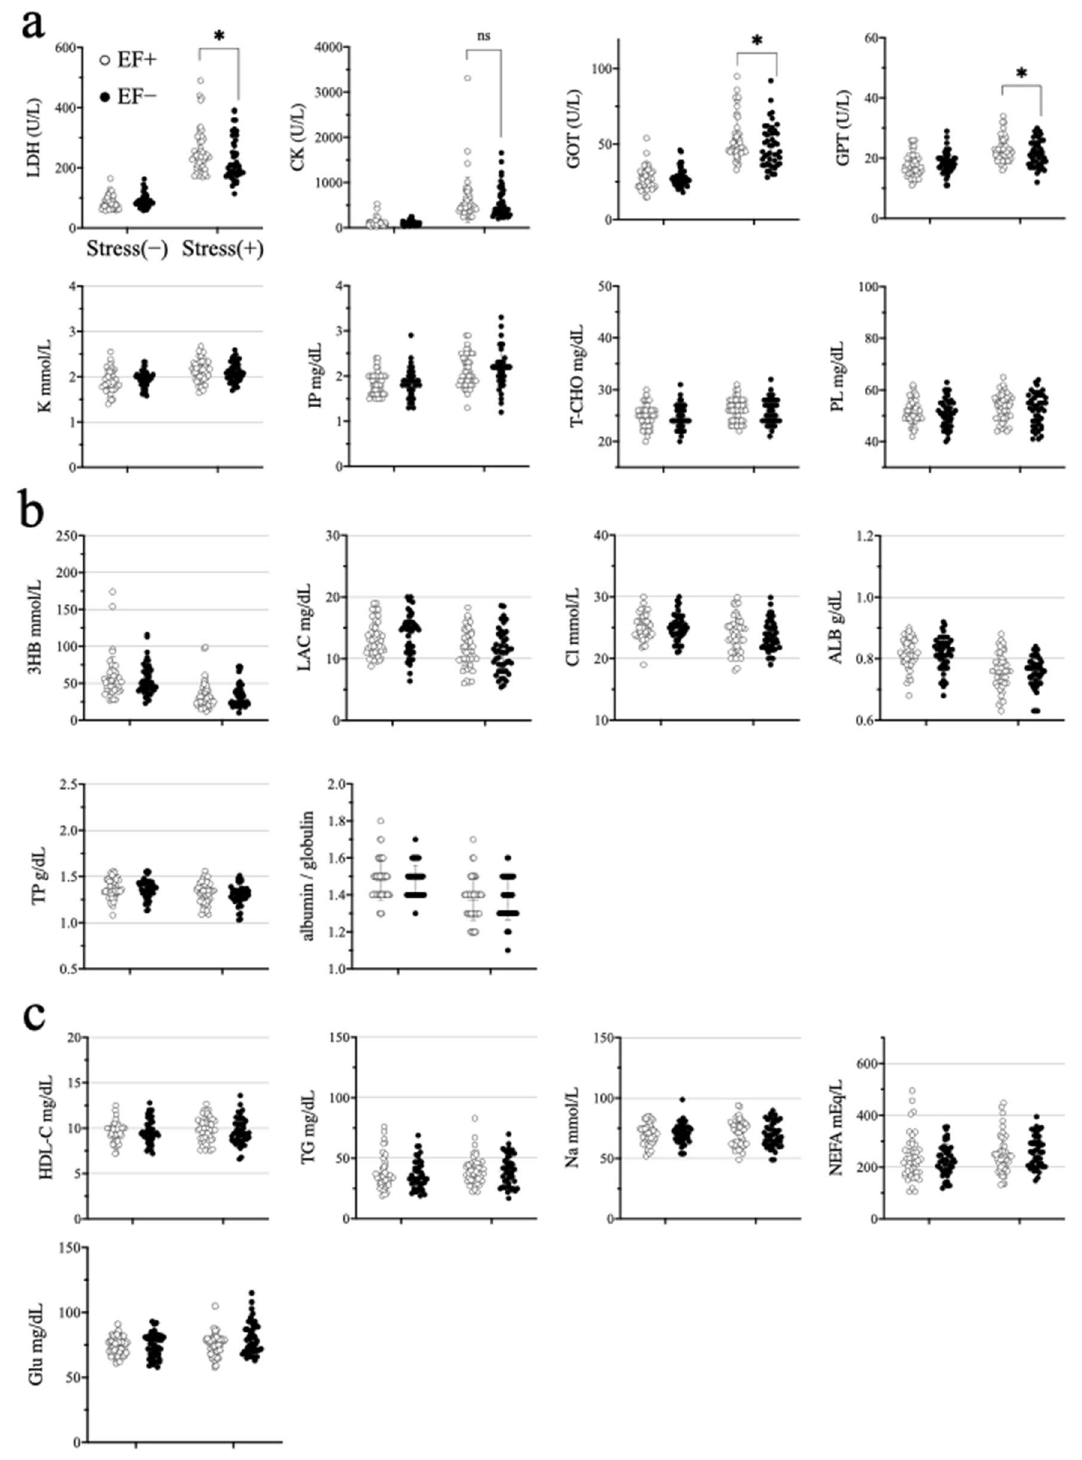
Figure 3. Effect of immobilisation and electric field exposure in biochemical tests (n = 46). ( a ) Up-regulated by immobilisation; ( b ) down-regulated by immobilisation; ( c ) not